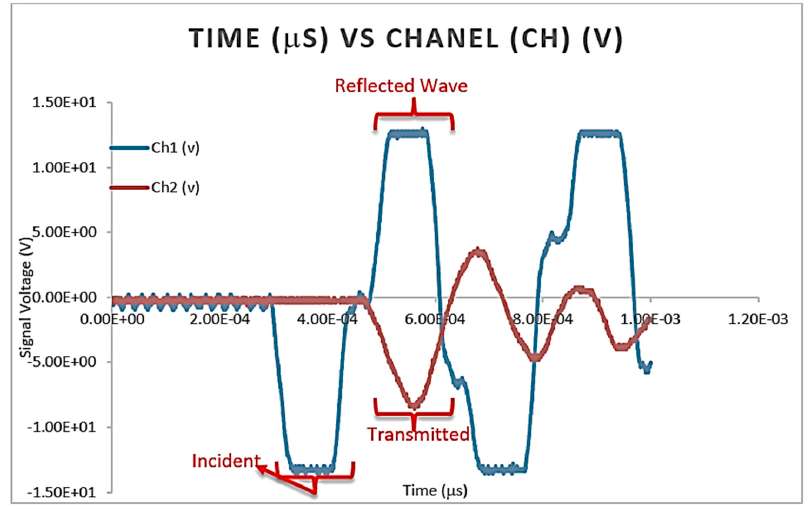
Figure 11. Typical waves obtained from Split Hopkinson pressure bar (SHPB) test for toughened epoxy structural adhesives. structural adhesives. Table 3. Parameters of the split Hopkinson pressure bar test equipment.